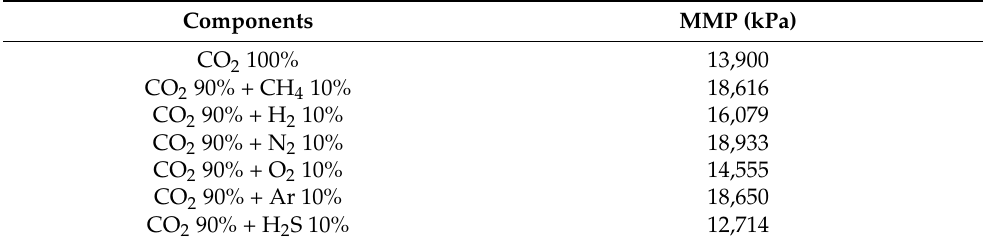
Table 8. Minimum miscibility pressures (MMPs) calculation using the slim-tube method with various CO 2 mixtures.